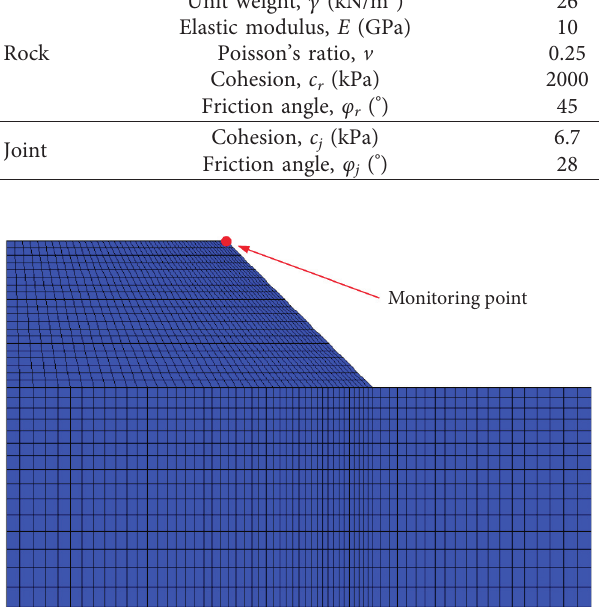
Figure 2: The mesh discretization and the layout of the monitoring point of the 2D